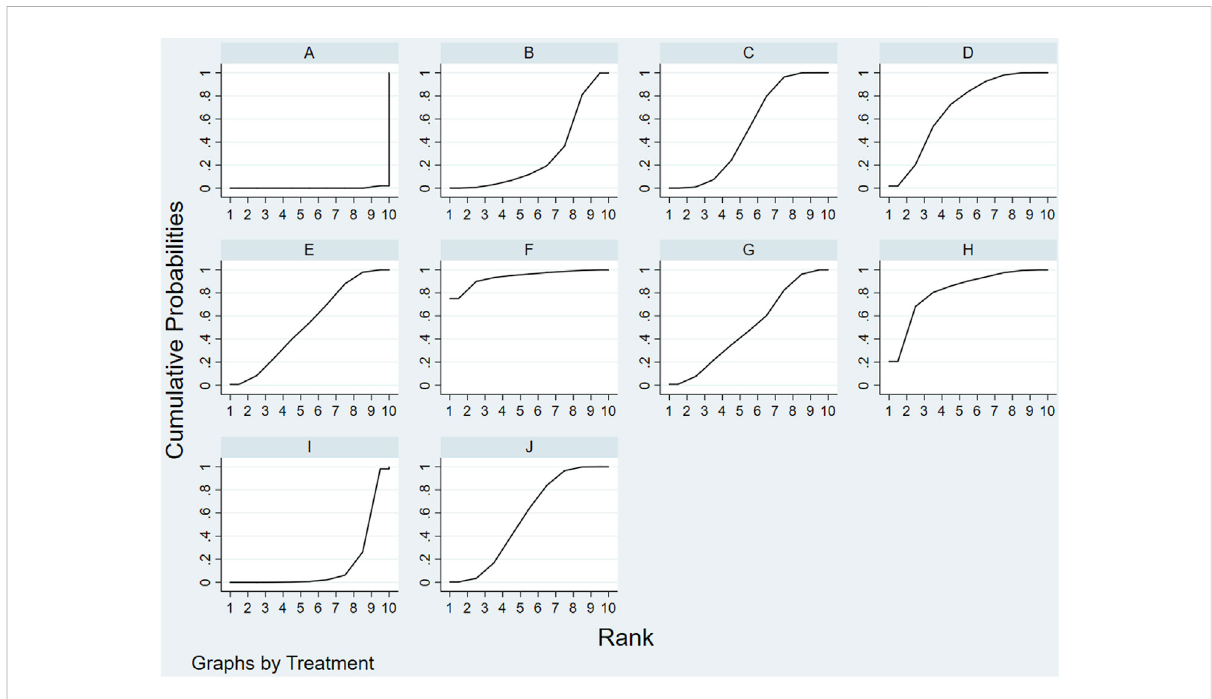
FIGURE 4 Rankofthecumulativeprobabilities foroutcomes:overallresponserate. (A) :ME; (B) ME+CXQ; (C) ME+DH; (D) ME+DSCXQ; (E) ME+DZHS;